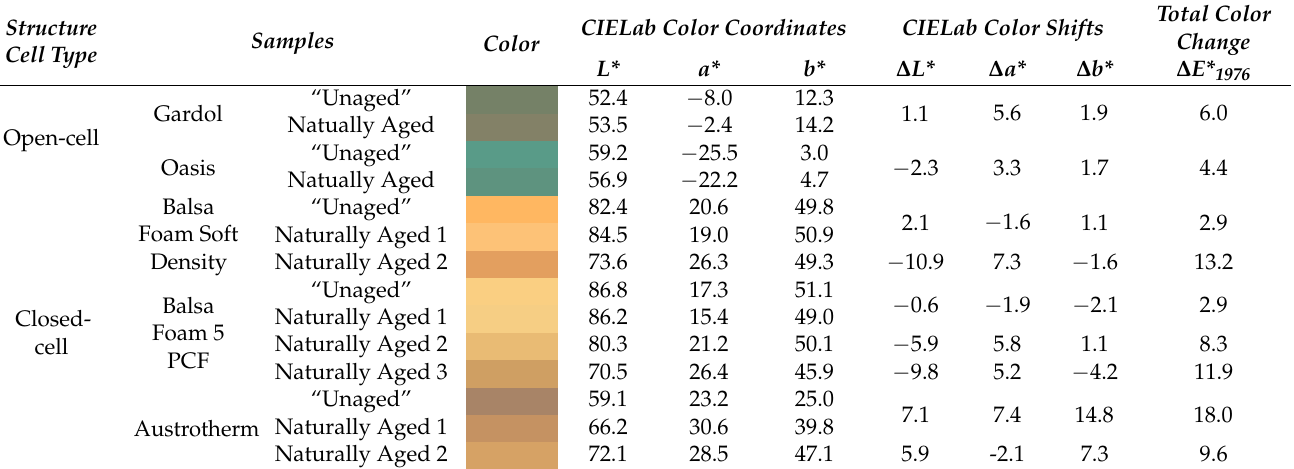
Table 2. L* , a *, b* as CIELab color coordinates obtained by FORS analyses on the “Unaged” and open- and closed-cell PF foams. Their shift and the total color change ( ∆ E* ) are also reported. Structure Cell